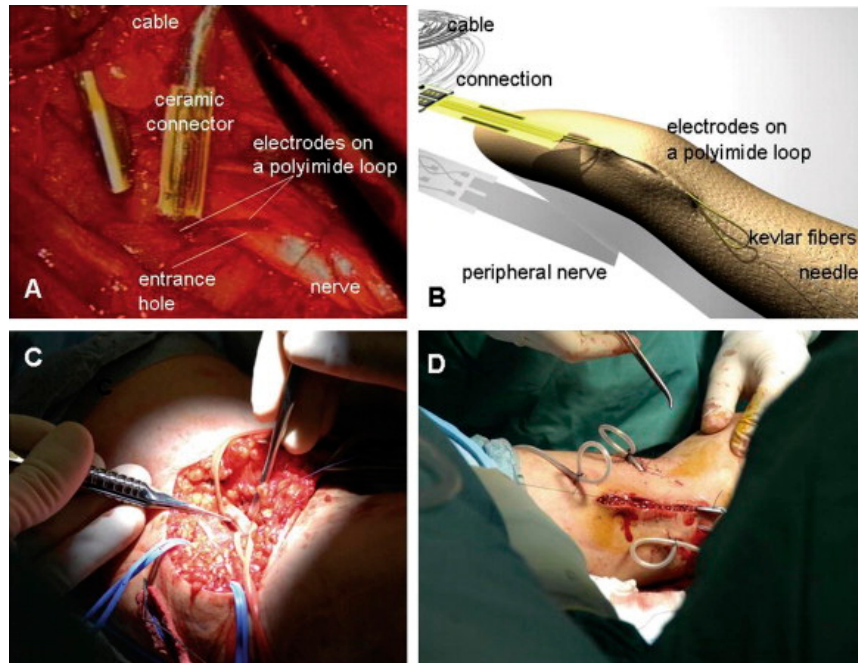
Figure 15. Surgical implantation of a tf-LIFE4 intraneural electrode implant based on a polyimide (PI2611) substrate (10 µm in thickness and 5 cm in length). ( A ) A magnified photographic view of implant components during surgical implantation; ( B ) schematic illustration of the overall tf-LIFE4 implant system; ( C ) photographic view median nerve, tf-LIFE4 electrode and cable during surgical implantation; ( D ) external transit cables after implantation. Reproduced from [33], with permission from © 2010 Elsevier.